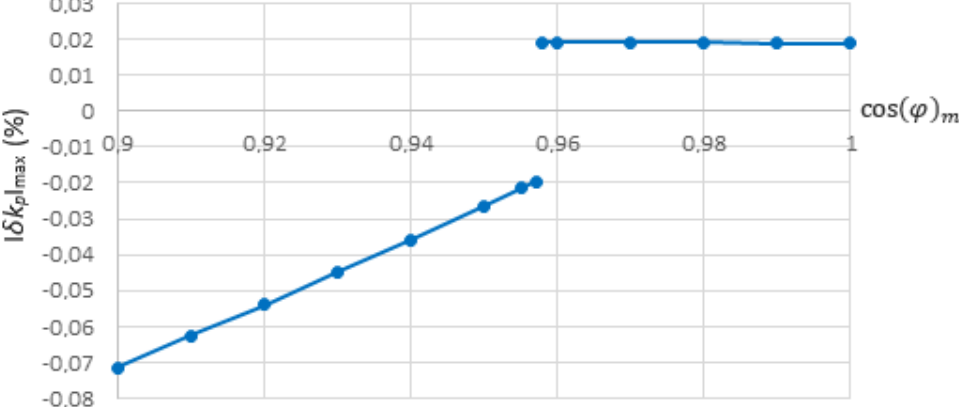
Figure 10. The dependence of the adjustment gain error on the lower bound of load power factor and on the upper bound of wire resistance.